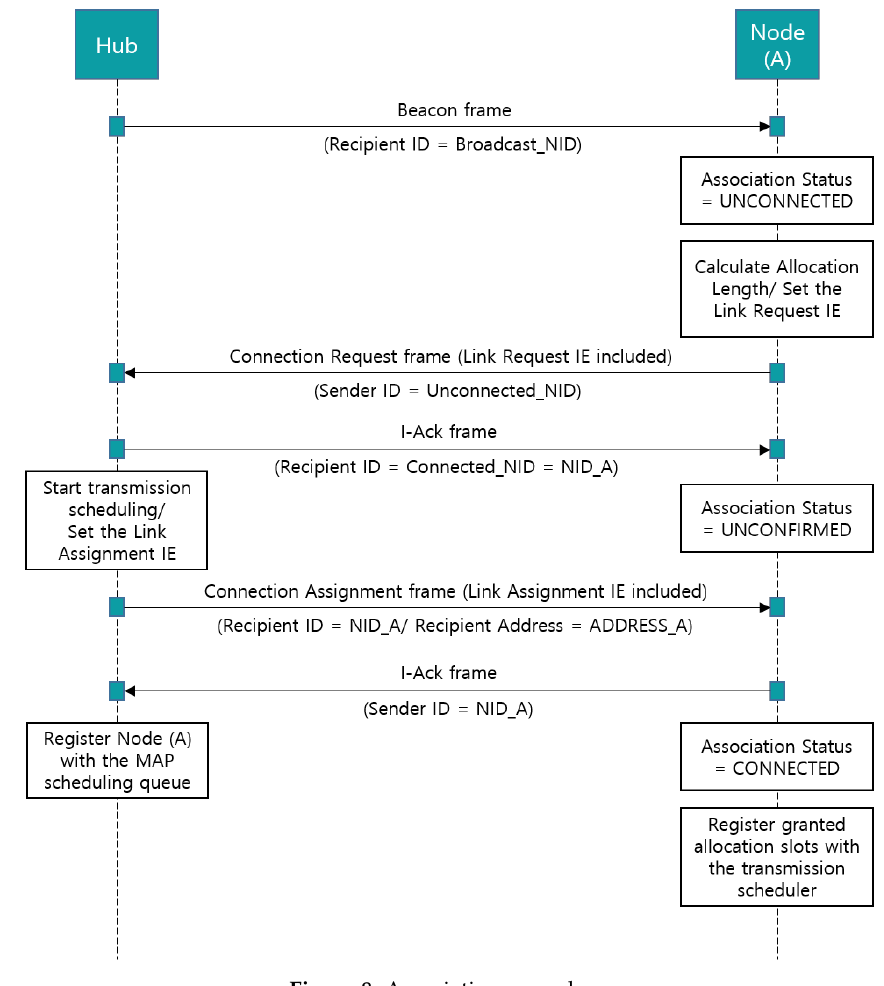
Figure 8. Association